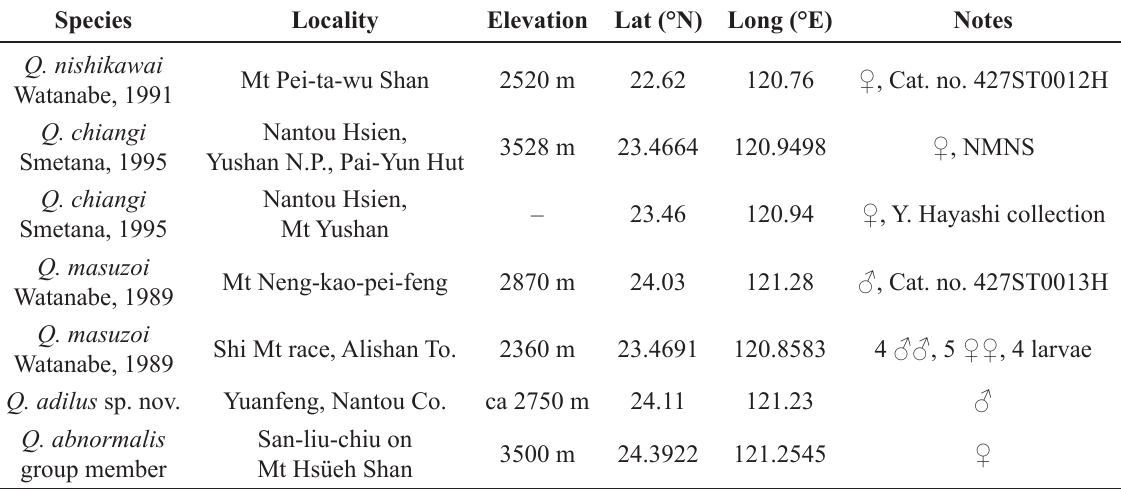
Table 2. Label information on the currently known specimens of the Quedius abnormalis group from